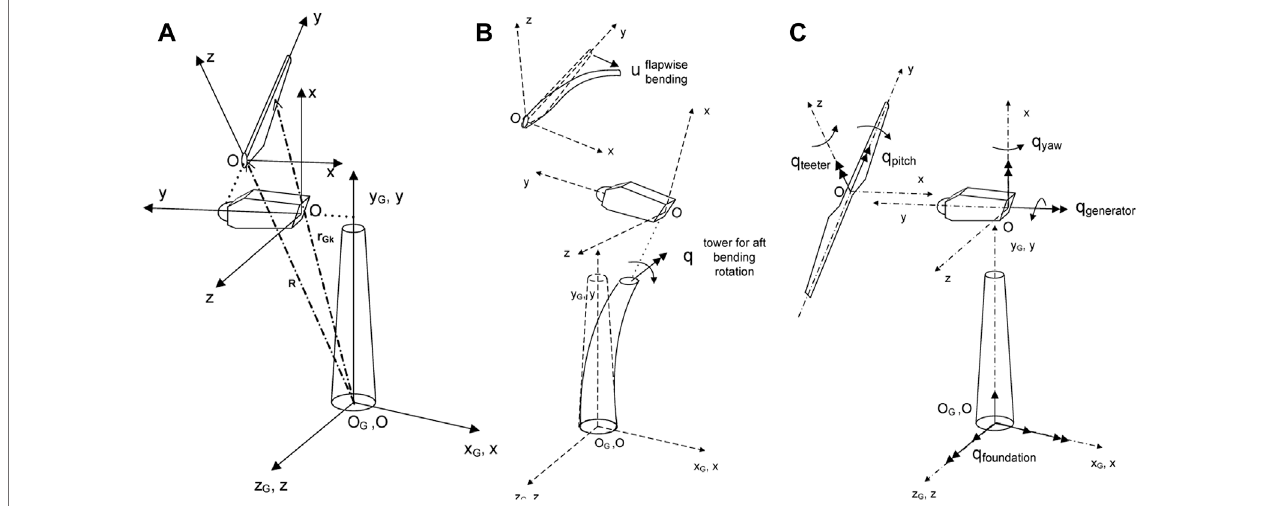
FIGURE 3 | (A) Wind turbine inertial frame and local component local frames, (B) multibody kinematics realization, examples of elastic q DOFs, (C) multibody kinematics realization, examples of controlled or free motion q DOF.